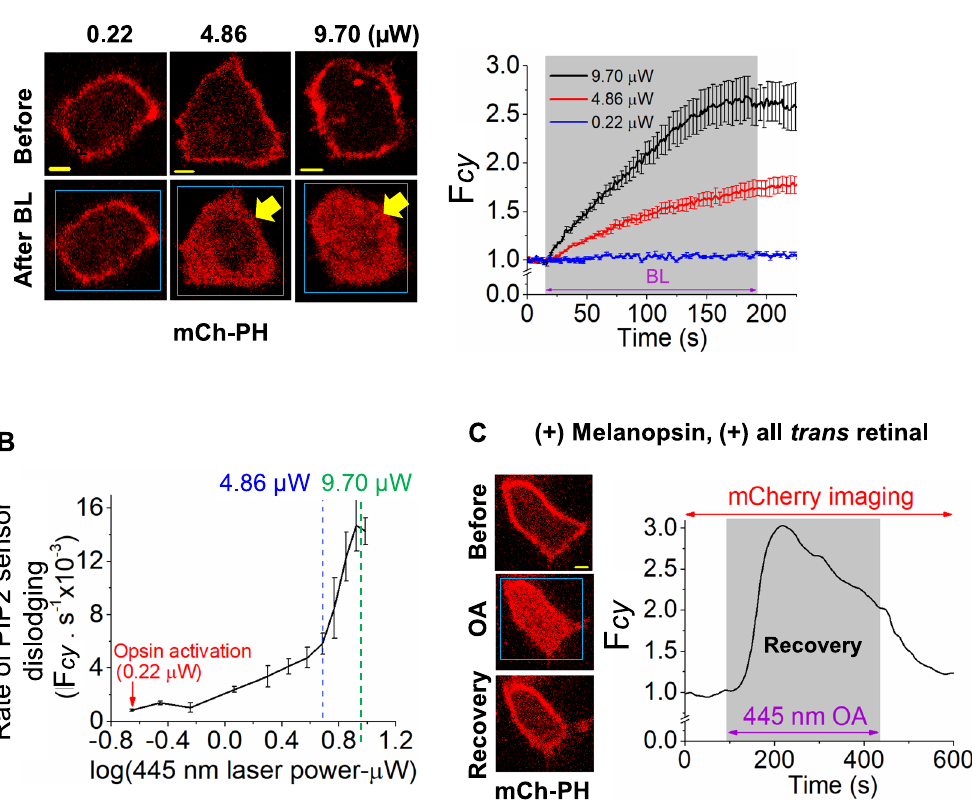
Figure 1. Comparison of photoreceptor dependent PIP2 hydrolysis vs photoreceptor independent PIP2 sensor translocation by photoexcited retinal. ( A ) Images of HeLa cells incubated with 50 µ M ATR (retinal) expressing PIP2 sensor (mCherry-PH). Both images and the plot of F cy vs time show that cells exposed to 0.22 µ W 445 nm blue light did not respond, while cells exposed to 4.86 µ W and 9.70 µ W blue light exhibited mCherry-PH translocation to cytosol (mean ± S.E.M.). ( B ) The plot of initial PIP2 sensor dislodging rate vs laser power of 445 nm blue light. (mean ± S.E.M., n = 6 cells in each experiments). ( C ) Images of HeLa cells expressing Gq- coupled Melanopsin and mCherry-PH. Cells were incubated with ATR (50 µ M) for 5 minutes. A significant PIP2 hydrolysis was observed upon optical activation (OA = blue box) of melanopsin using short pulses of blue light (0.22 µ W of 445 nm). Recovery of PIP2 sensor to the PM was observed even the blue light exposure is continued. The plot shows the dynamics of PIP2 sensor translocation in cytosol. Mean and S.E.M. are from 3 < independent experiments. (blue light (BL) = blue box). Scale = 5 µ